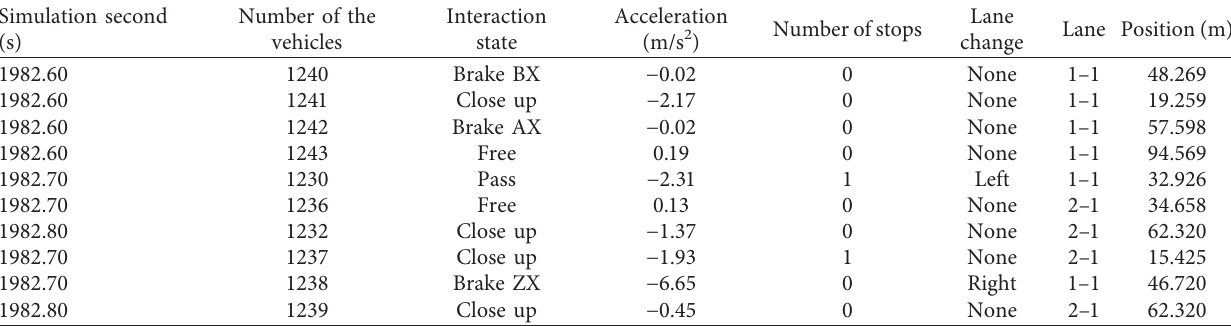
Table 1: Sample attribute values for each vehicle from “Vehicle Record.”